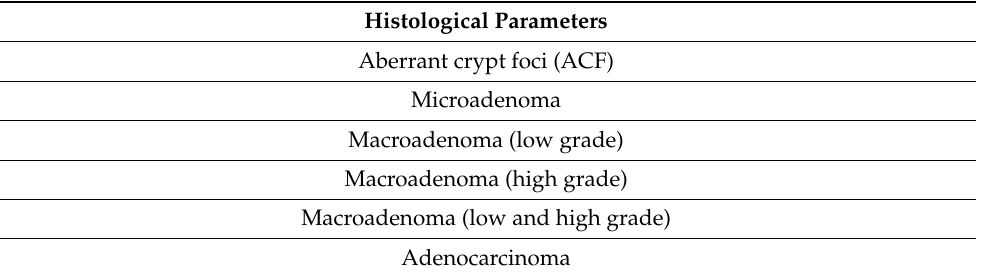
Table 3. The extent of